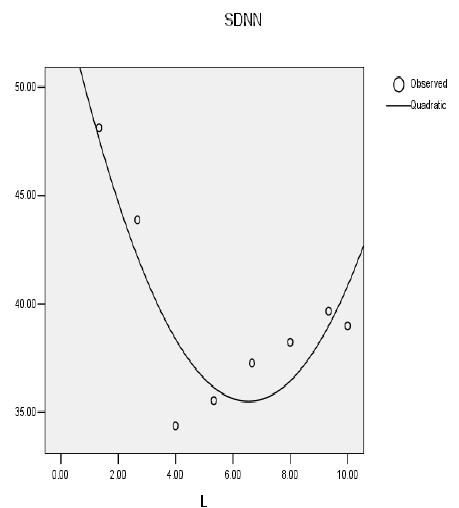
Fig.5. The regression line between the straight line length and